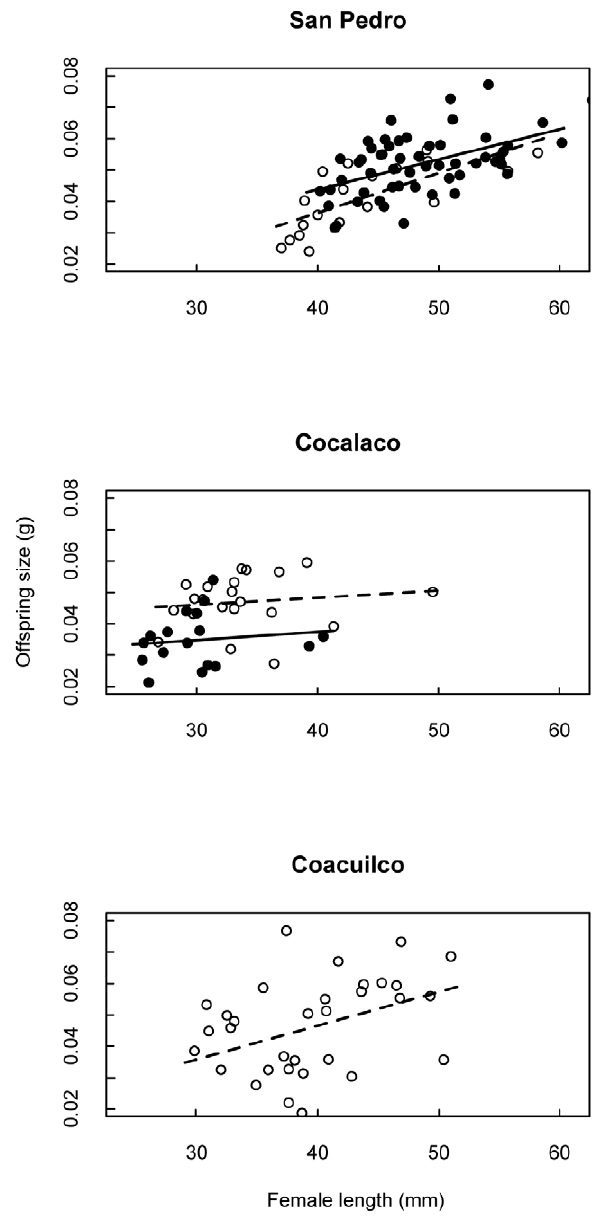
Figure 3. Female size and offspring size. Solid points are data from 2008; open points are 2010. Female length is significantly related to offspring size at San Pedro (top panel) and Coacuilco (bottom panel). The trend at Cocalaco in each year was not significant. A separate linear model was estimated for each year of data at Cocalaco and San Pedro as female size varied significantly with year.